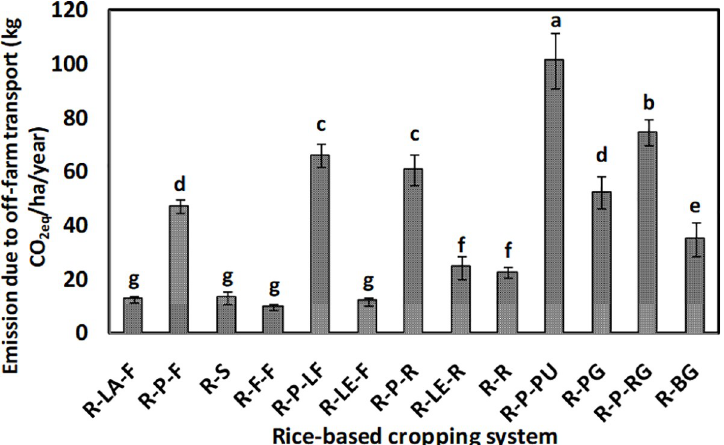
Fig 7. Greenhouse gases (GHGs) emission due to off-farm transport from different rice-based cropping systems of the study area. [here, R-LA-F: rice-lathyrus- fallow, R-P-F: rice-potato-fallow, R-S: rice-sunflower, R-F-F: rice- fallow-fallow, R-P-LF: rice-potato-ladies finger, R-LE-F: rice-lentil-fallow, R-P-R: rice-potato-rice, R-LE-R: rice-lentil- rice, R-R: rice-rice, R-P-PU: rice-potato-pumpkin, R-PG: rice-pointed gourd, R-P-RG: rice-potato-ridge gourd, R-BG: rice-bitter